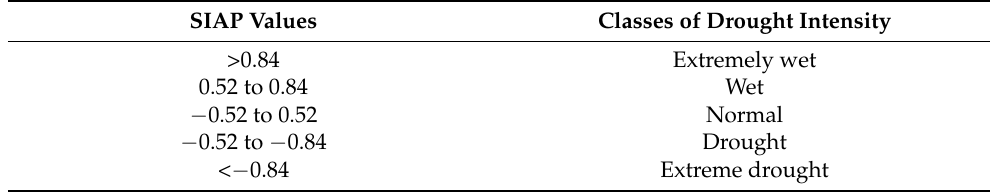
Table 3. Classification of drought based on SIAP